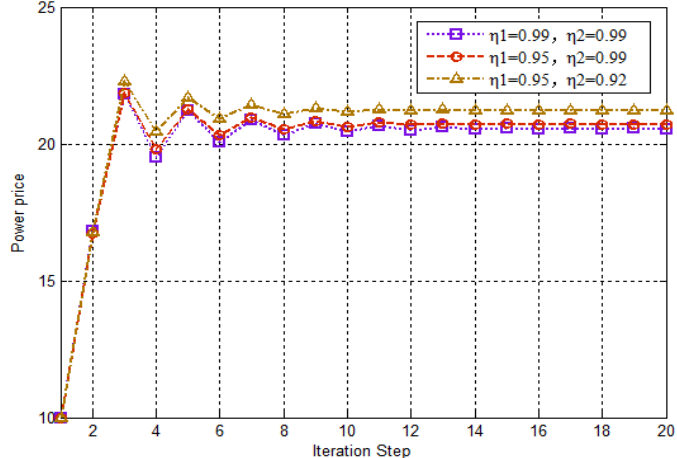
Figure 3. Power price offered by SGO i versus the iteration step, in which its initial price p i = 10, C 1 = C 2 = 3, and S 1 = 6, S 2 = 7,